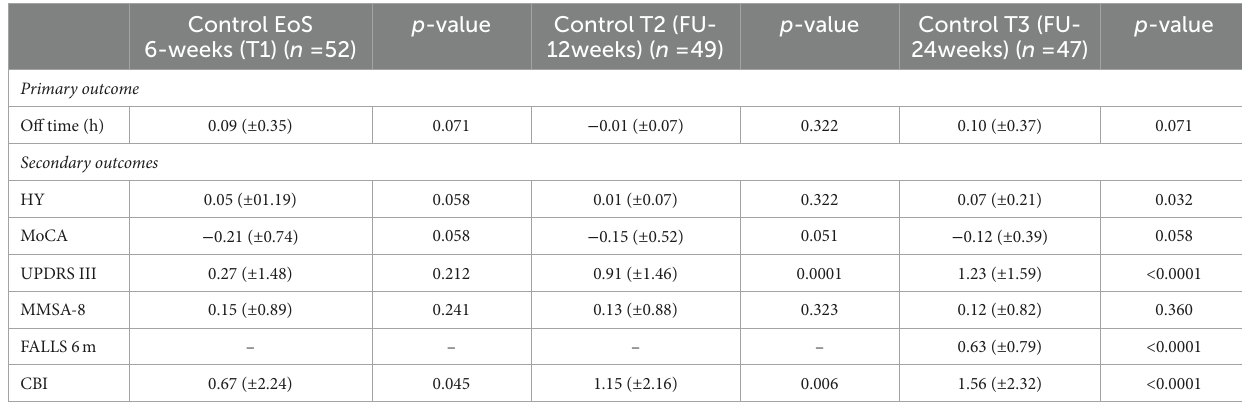
TABLE 6 Six-weeks (T1), 12-weeks (T2) and 24-weeks (T3) follow-up outcome measures for all participants and comparison with baseline (T0) within the control